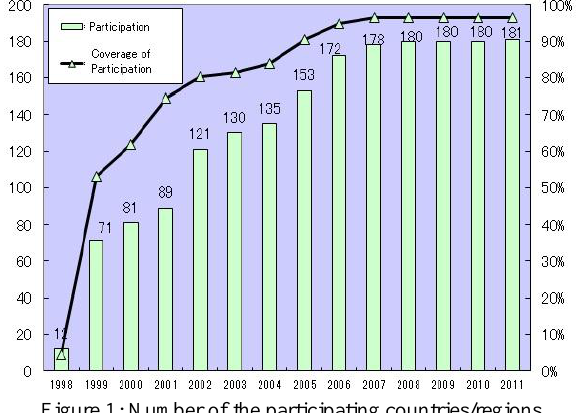
Figure 1: Number of the participating